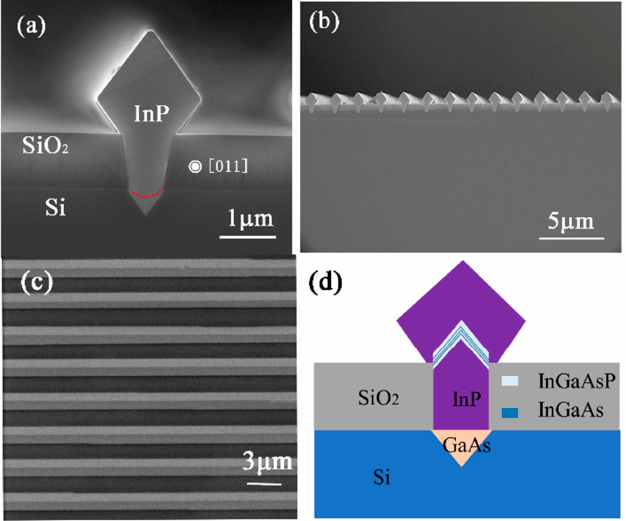
Figure 1. Cross-sectional SEM image of ( a ) a InP microwire with RRW on the pre-patterned Si sub-strate, and ( b ) an array of InP microwires with RRWs. ( c ) Plan-view SEM image of the array of InP microwires with RRWs. ( d ) Schematic diagram of SCH–MQW microwire with RRW.